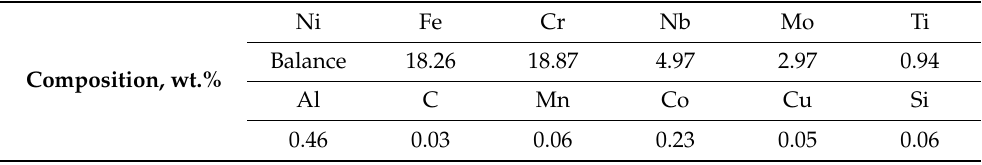
Table 1. Nominal composition of Inconel 718 powder used in this work.